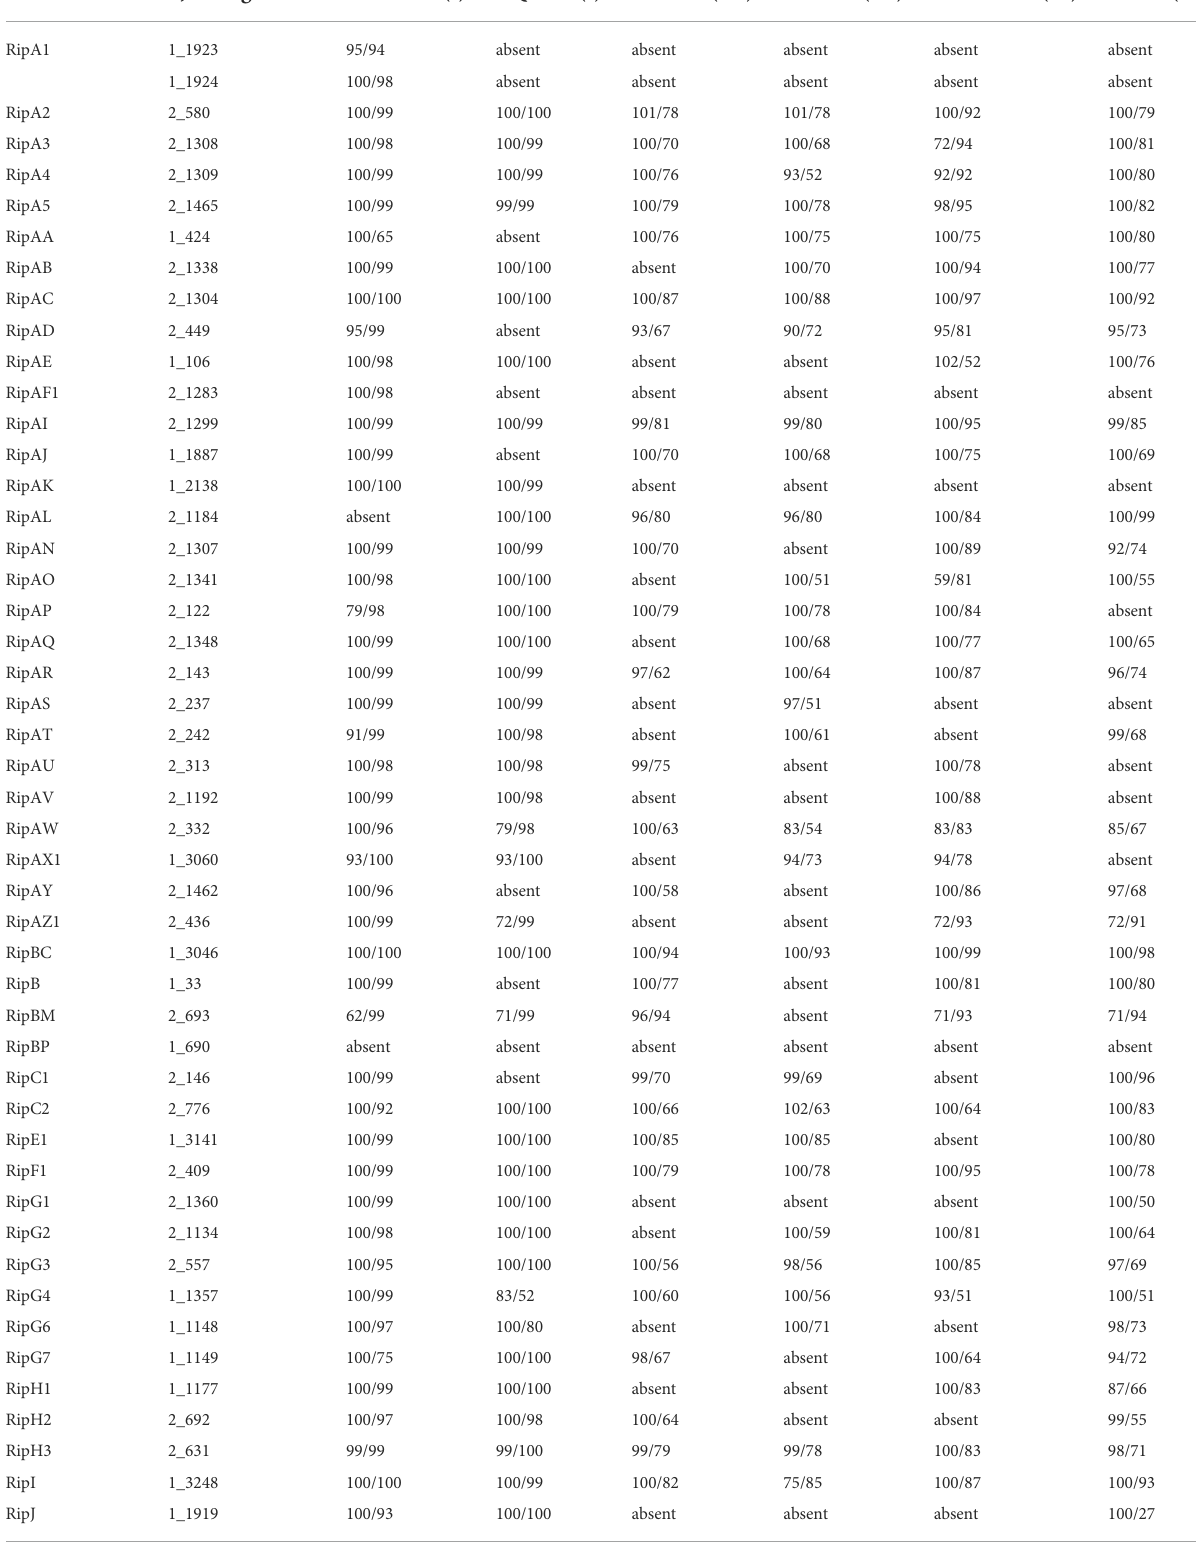
TABLE 2 Summary of type III effector proteins genes (Coverage%/Identity%) in FJ1003 and other